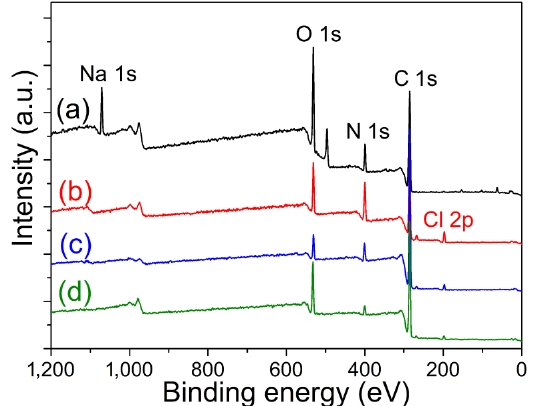
Fig. 5 Survey XPS spectra of (a) CNPs-Na, (b) CNPs-Cl, (c) A-g-CNPs, and (d)